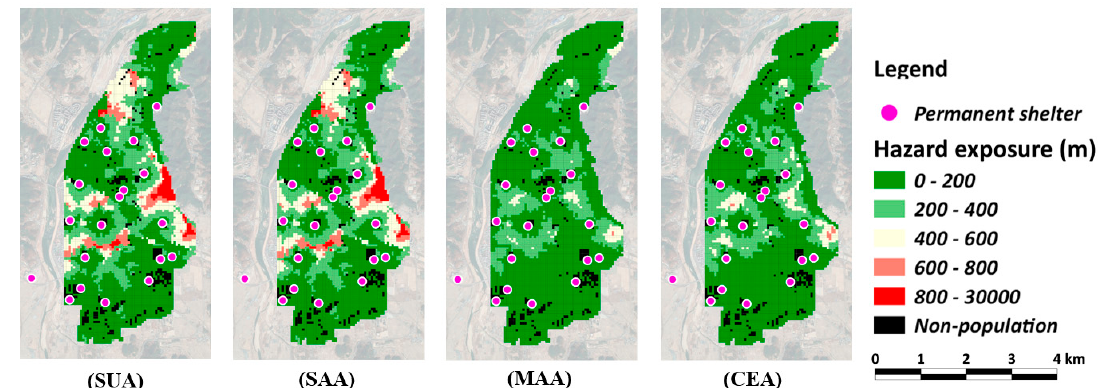
Figure 8. Road hazard for each route analysis.